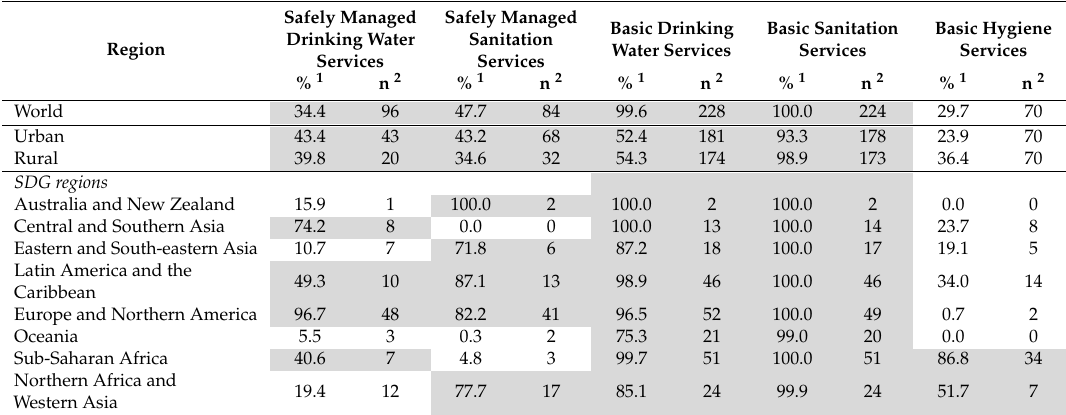
Table 4. SDG baseline data coverage for drinking water, sanitation and hygiene